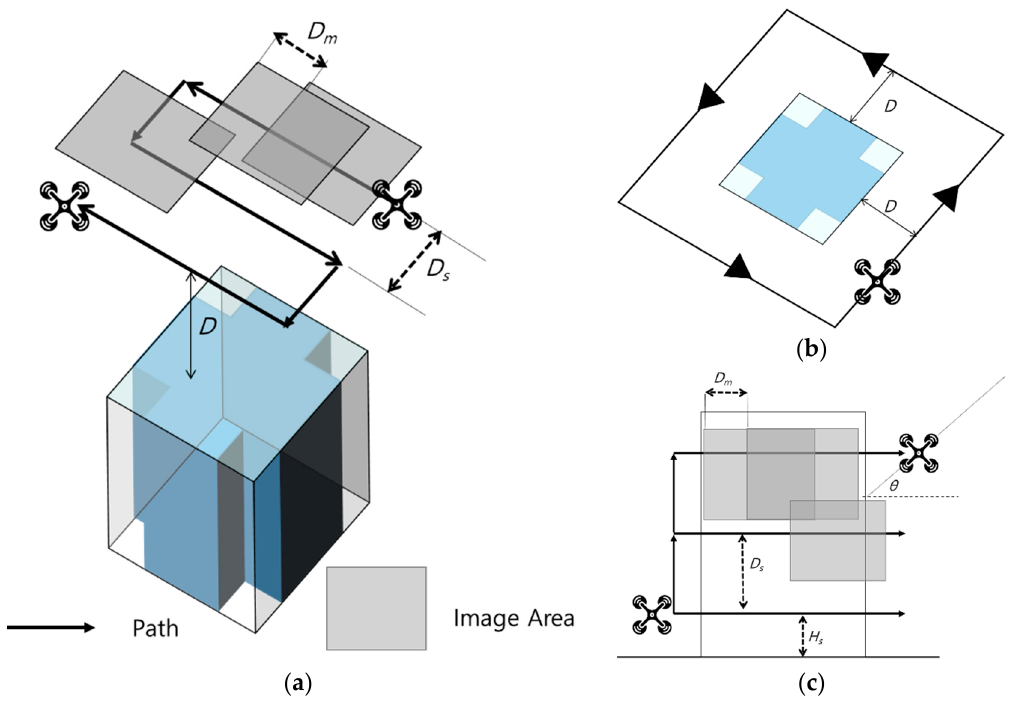
Figure 4. ( a ) Isometric view of nadir photogrammetry path, ( b ) Top view of oblique photogrammetry path, and ( c ) Side view of oblique photogrammetry path.